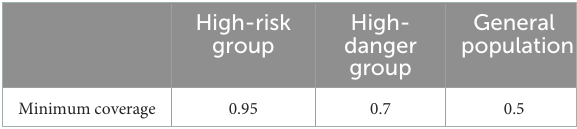
TABLE 3 Minimum coverage for each